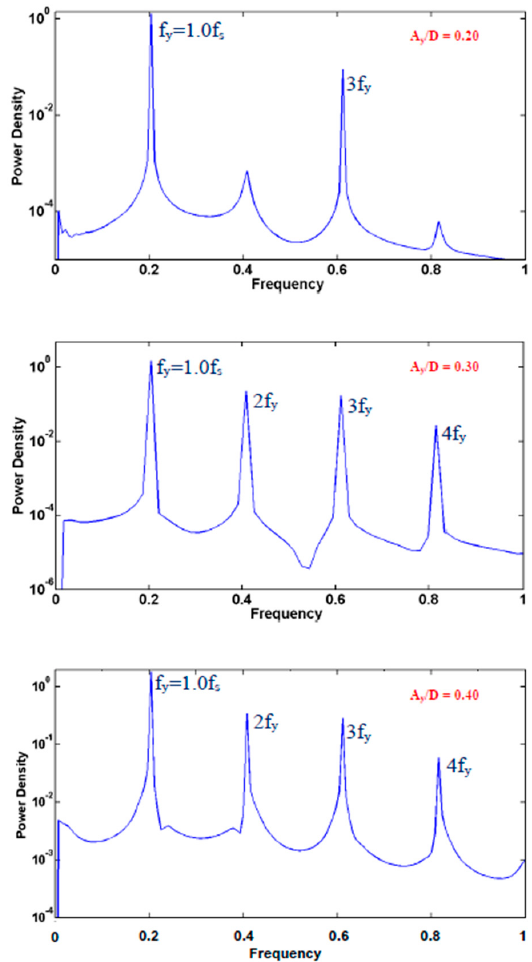
Figure 9. Spectra of the lift force coefficient for F = 1.0 and A y /D = 0.20, 0.30, 0.40, for the clockwise cylinder oscillation.